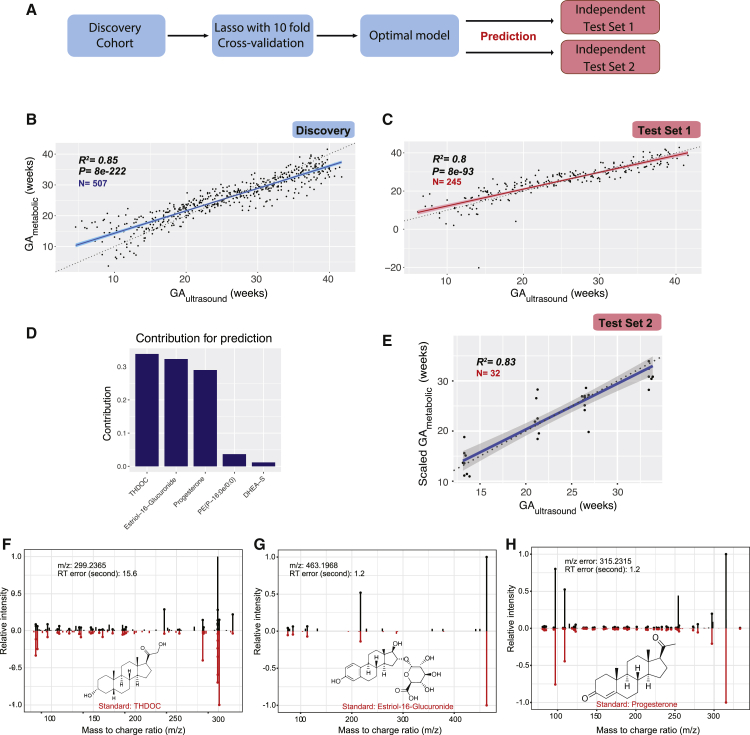
Metabolic Clock Of Pregnancy: Five Metabolites Selected by Machine Learning Can Accurately Predict the Timing of Normal Pregnancy Progression in Both a Discovery and Two Validation Cohorts(A) Design of the analytical pipeline.(B and C) Gestational age (GA) predicted by the linear model consisting of five identified metabolites (GAmetabolic, y axis) highly correlates with clinical values determined by the standard of care (by first-trimester ultrasound [GAultrasound] x axis) in the Discovery (B) and the validation cohort (test set 1) (C). Note that two samples presented as outliers in the validation cohort, possibly because of occasional mass-spectrometry signal instability in given samples. The 95% confidence interval for the linear regression is represented by the gray area.(D) Contribution of the five metabolites to the gestational age prediction model.(E) Gestational age predicted by the five metabolites (GAmetabolic, y axis, scaled) correlates with clinical values determined by the standard of care (by first-trimester ultrasound [GAultrasound] x axis) in the test set 2 cohort. The 95% confidence interval for the linear regression is represented by the gray area.(F–H) Confirmation of the metabolites predicting gestational age in the metabolic clock model by standard compounds, THDOC (F), estriol-16-glucuronide (G), and progesterone (H) (see two additional compounds PE(P-16:0e/0:0) and DHEA-S in Figures S4E and S4F). Measured MS/MS spectral fragmentation profiles (top, in black) matching chemical standards (bottom, in red). Note that the discovery results were from the 10-fold CV to avoid over-fitting (see STAR Methods).See also Figures S4 and S5 and Tables S2–S4.